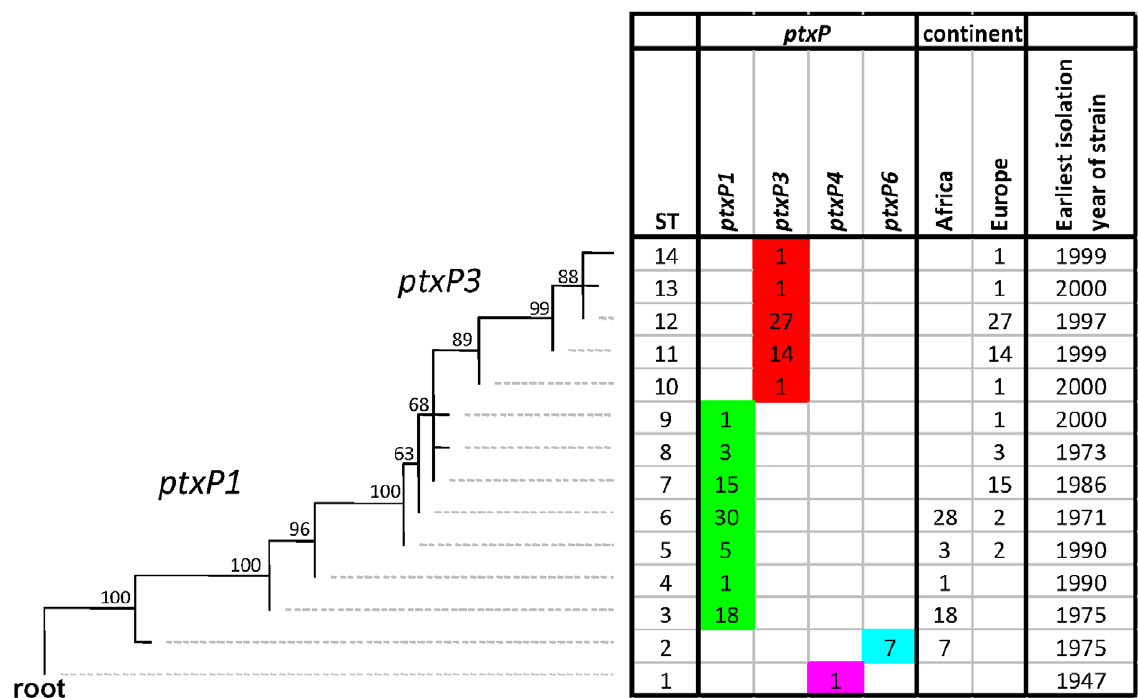
Figure 1. Maximum Parsimony tree of 125 B.pertussis isolates based on 87 SNPs. The ptxP alleles, continent of origin and the year of isolation of the oldest isolate are indicated. The numbers refer the number of isolates for each ST. Bootstrap values are indicated in the tree. Abbreviation, ST; SNP type.